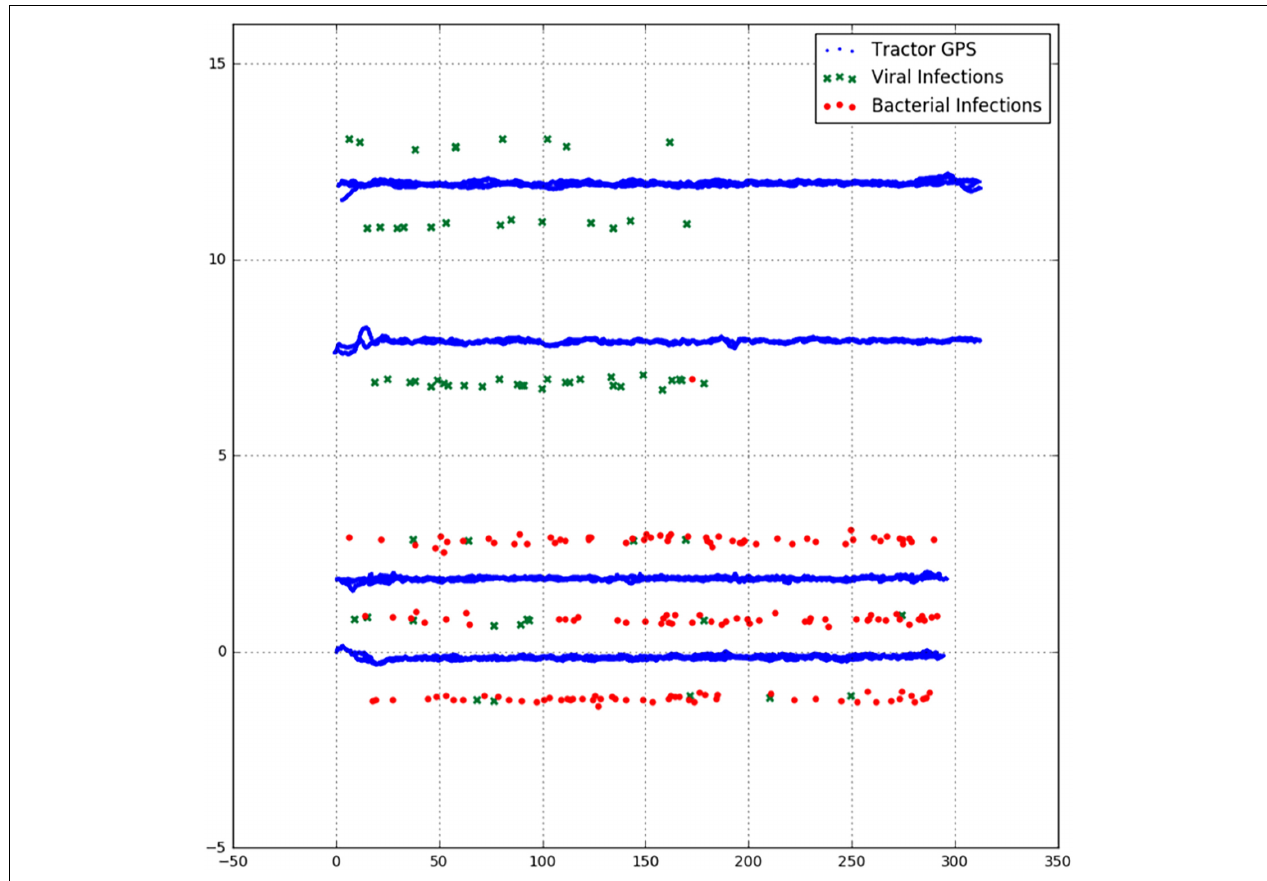
FIGURE 5 | The GNSS positions of the RTK rover, labeled as viral or bacterial infection and the GNSS position of the tractor driving back and forth over the rows. The units on the axes are scaled to half the inter row distance and uniform in both directions.